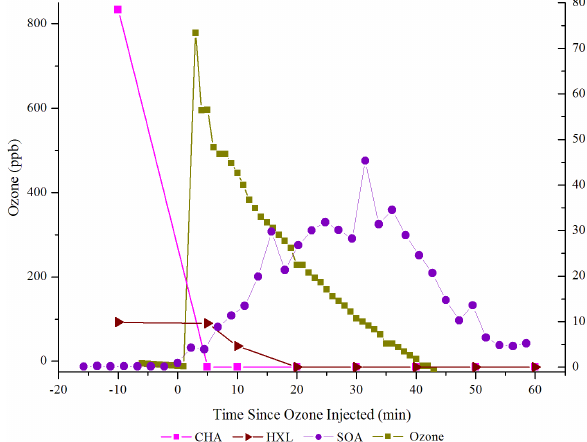
Fig. 6a. Approximately 0.5kg of grass clippings were placed in the experimental chamber, which was then filled with zero air. Initial concentrations of CHA and HXL were 8.0 ( ± 2) × 10 2 µg/m 3 and 1.0 ( ± 0.8) × 10 2 µg/m 3 , respectively. At time zero ∼ 800ppb ozone was injected and both CHA and HXL concentrations dropped below the instrument detection limit within the first five min of the reac- tion, while SOA concentration increased for about 30min before reaching a maximum of ∼ 91µg/m 3 (wall-loss-corrected). Lines be- tween data points drawn to aid the